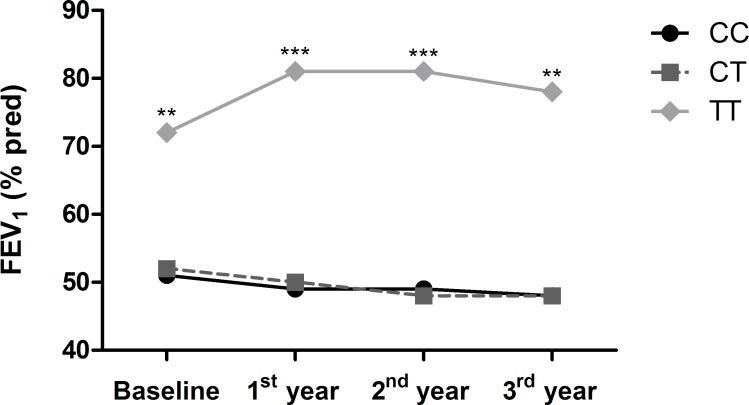
Lung function differences between rs3025020 genotypes in patients with Chronic Obstructive Pulmonary Disease over time.FEV1 (% pred) for the three genotypes of SNP rs3025020 (VEGFA gene) over time. The presence of allele T in homozygosis determined higher values of FEV1 (% pred) respect to the other genotypes. The differences remained constant for every visit (** p-value<0.01; *** p-value<0.001) and along 3 years of follow-up (p = 0.017). The sample size for each moment was: Baseline: N = 132; 1st year: N = 118; 2nd year: N = 98 and 3rd year: N = 87.